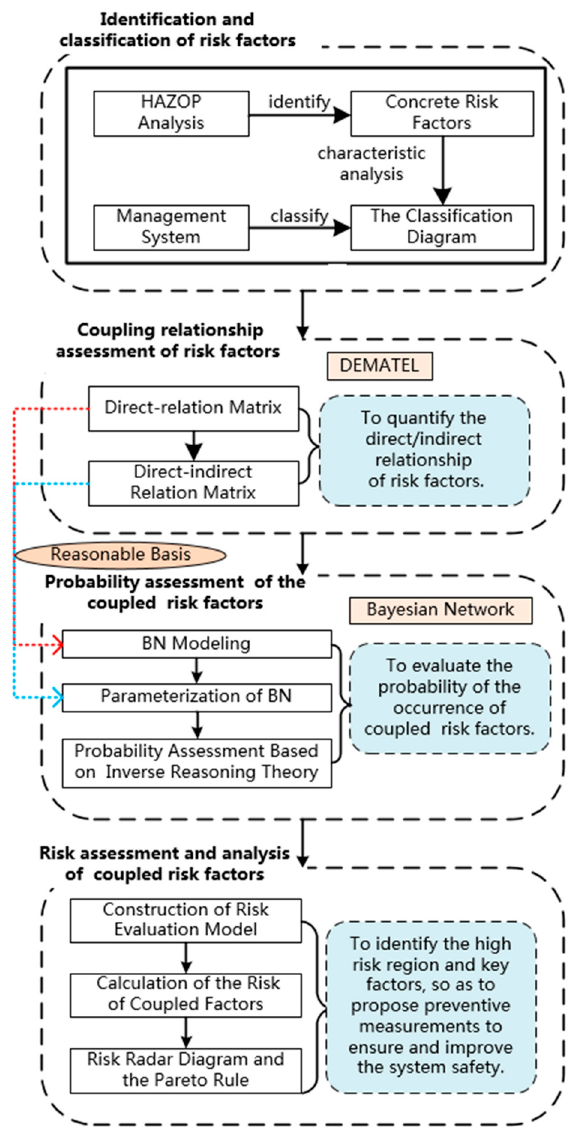
Figure 1. The description of the proposed method.